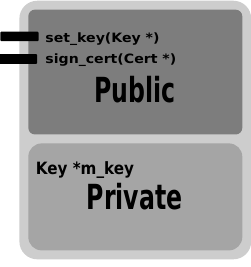
Figure 2. Salus’ memory access control model enables the creation of compartments that provide strong isolation guarantees to sensitive data. Secure communication primitives reduce the impact of an insecure